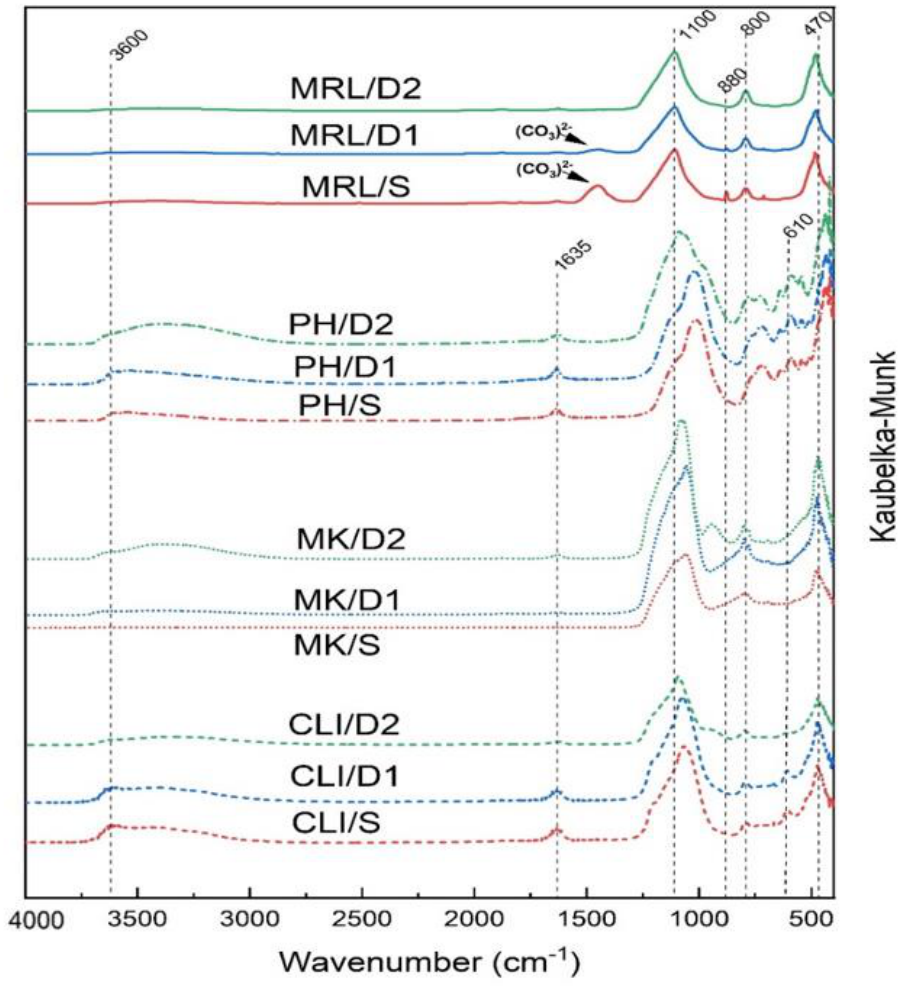
Figure 6. Di ff use reflectance infrared Fourier transform (DRIFT) spectra of CLI, MK, PH and